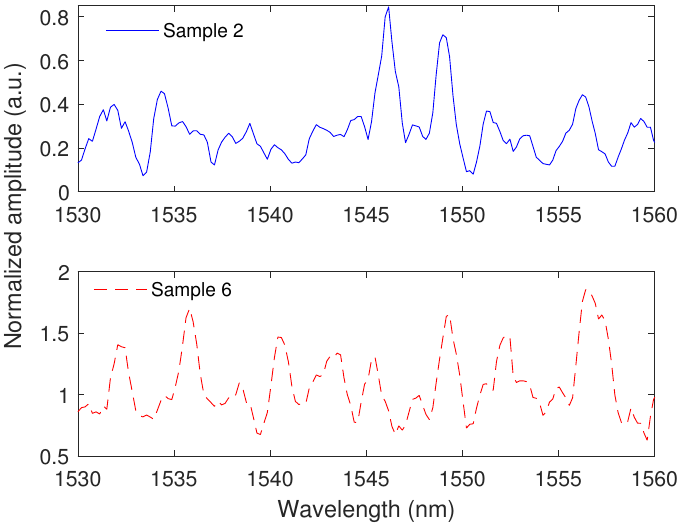
Figure 7. Transmitted spectrum (with normalized optical power) of the proposed SMS interferometer using two samples of the 3D-printed